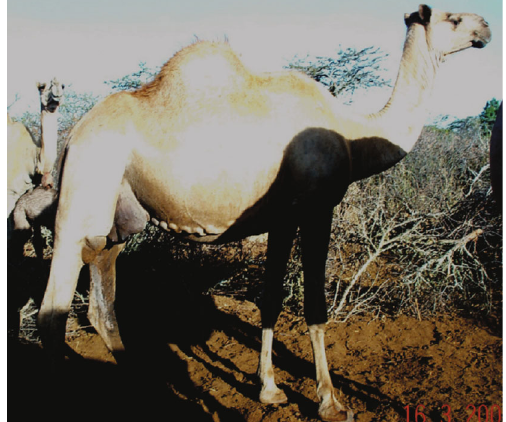
Figure 3: The Somali breeds. Source: [17] (with permission from